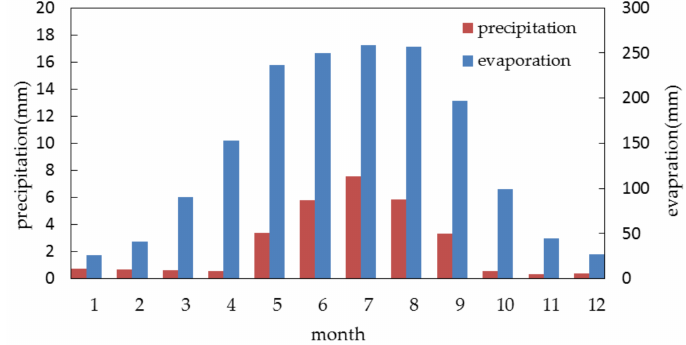
Figure 1. Monthly average precipitation and evaporation.